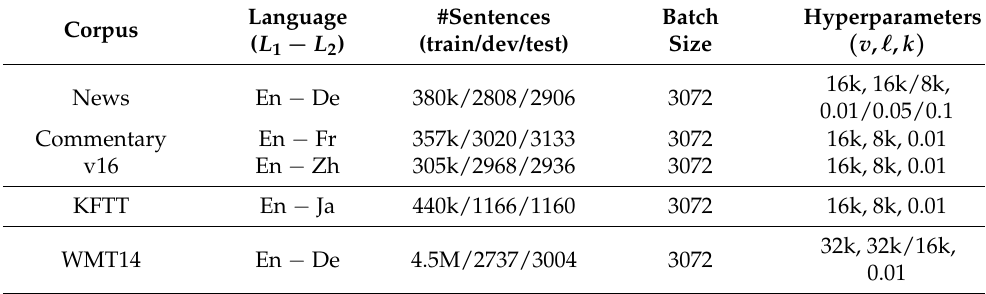
Table 2. Overview of the datasets and hyperparameters. The hyperparameter v (vocabulary size) is common to all algorithms (baselines and ours) and others ( (cid:96) and k ) are specific to LCP-dropout only. Language #Sentences Batch Hyperparameters Corpus